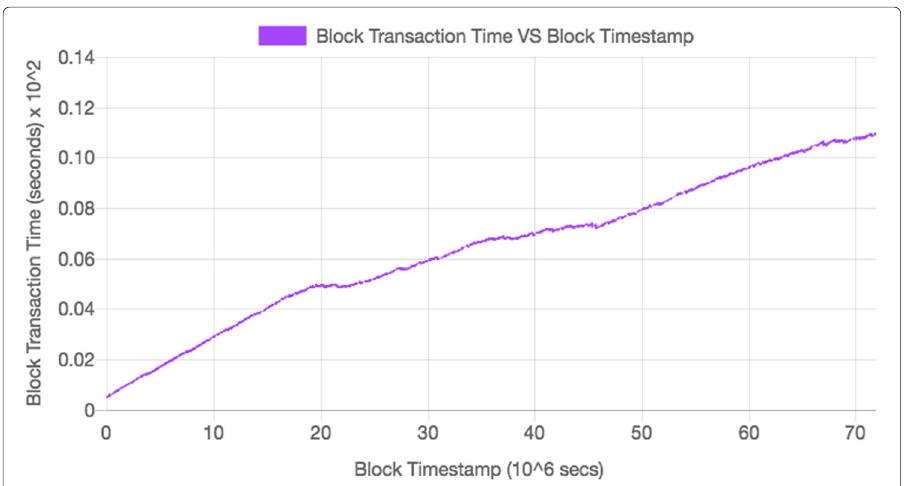
Fig. 8 Time elapsed between transaction submission and mining completion vs mining completion time. In this figure, we show the plot of the time difference between mining transaction submission and mining completion against mining completion time. This shows that as more blocks get added to the blockchain, the time taken to mine a block increases with the last added block potentially having the highest mining-wait